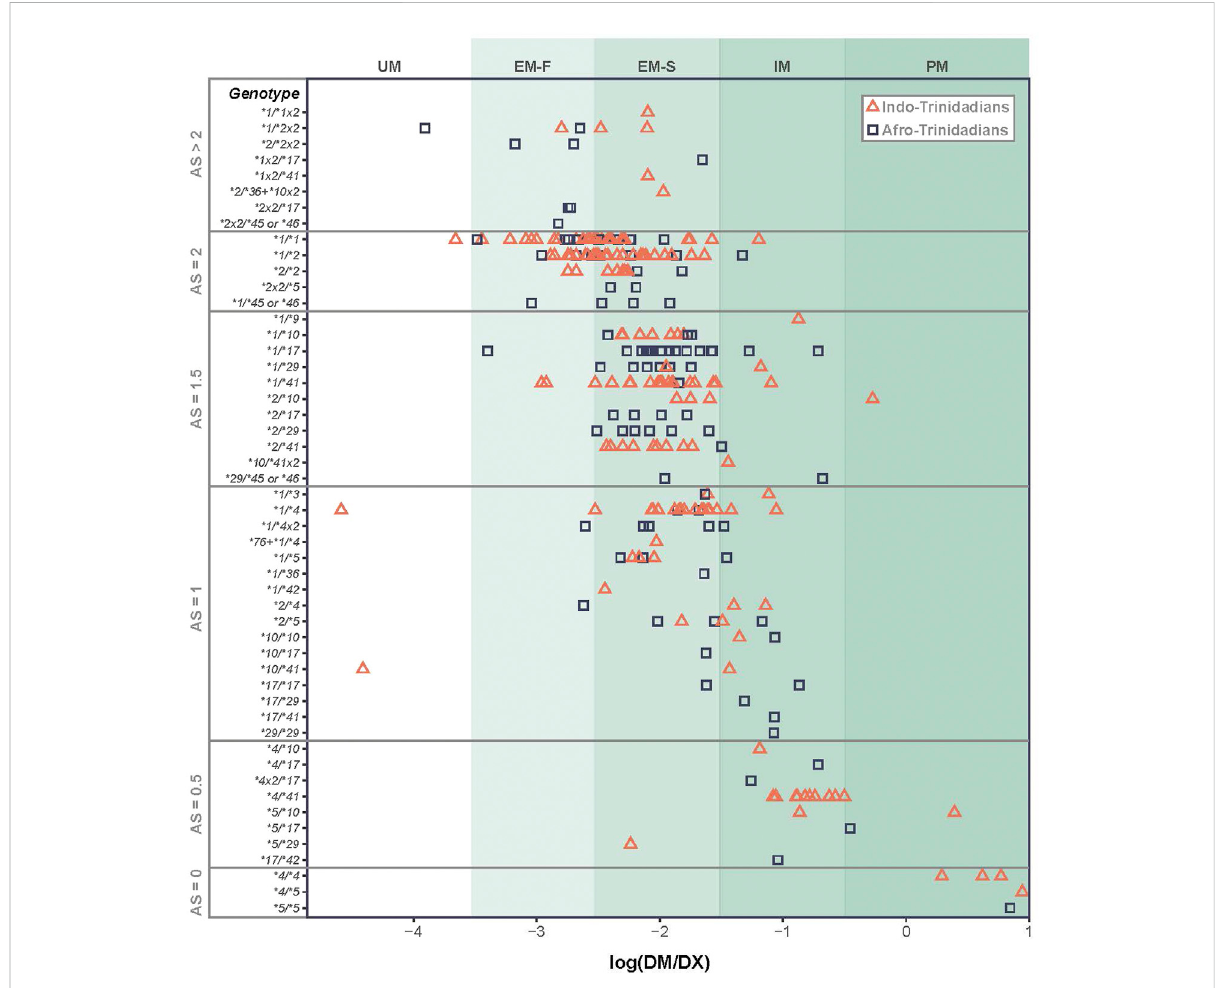
FIGURE 1 Variation in metabolism of dextro-methorphan (DM) to dextrorphan (DX) as a function of CYP2D6 * diplotypes. Diplotypes of the same AS and/ or*designationcanvaryinmetabolicratebyordersofmagnitude,givingrisetoambiguityofourunderstandingoflikelihoodofradicalcurebasedon these